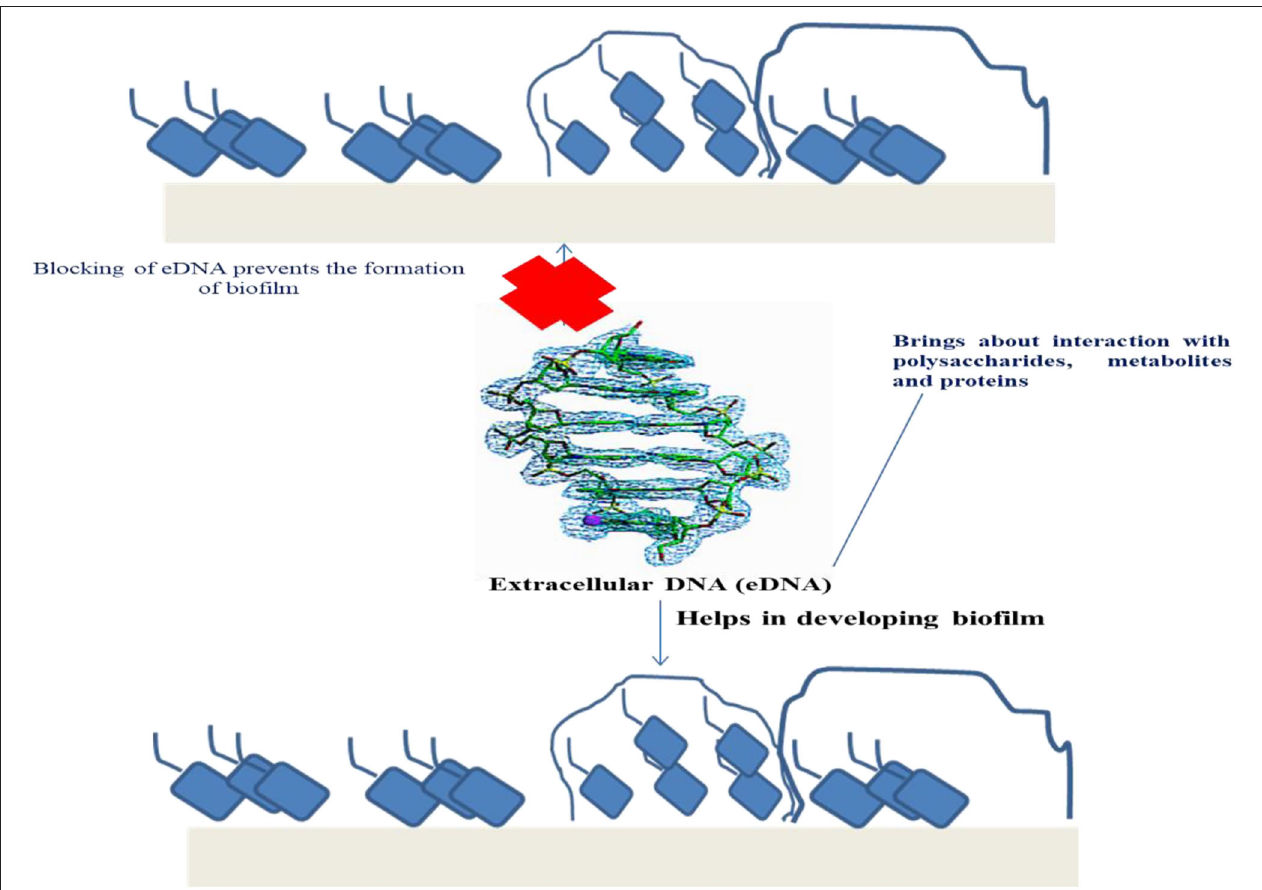
FIGURE 2 | Role of eDNA in the development and regulation of